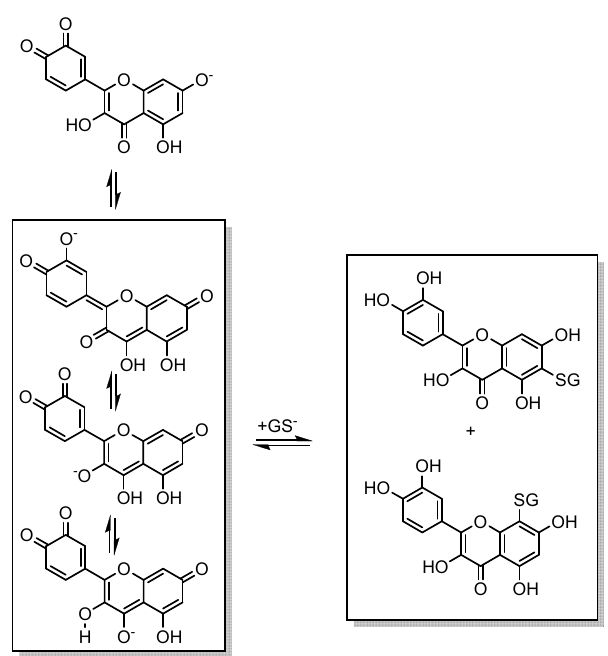
Scheme 1. Representation of the mechanism for the formation of the glutathionyl adducts of quercetin quinone/quinone methide at neutral